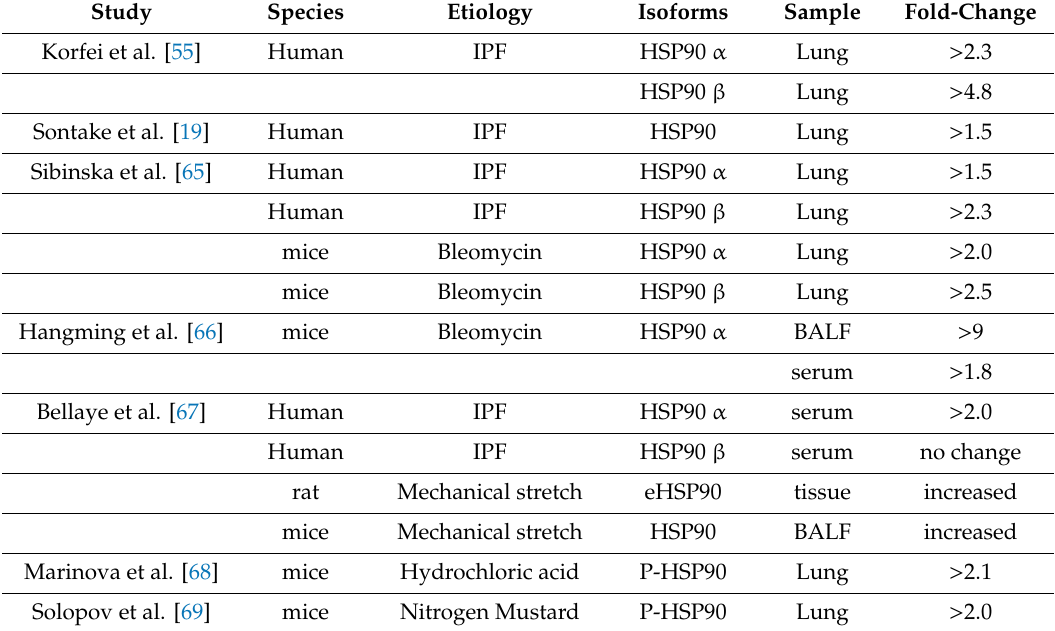
Table 2 collates significant evidence from di ff erent clinical and preclinical studies of IPF, were HSP90 was found increased (fold-change expression levels) compared to healthy controls ( p < 0.05). IPF: Idiopathic pulmonary fibrosis;